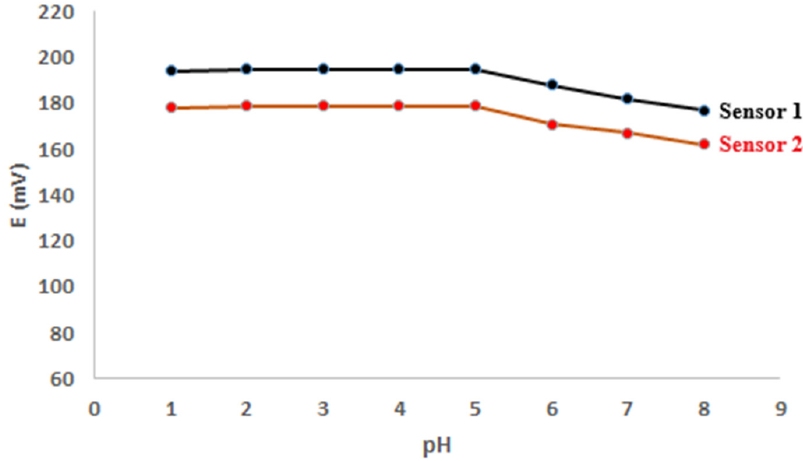
Figure 4. pH effect on the potential response of MOX membrane sensors.